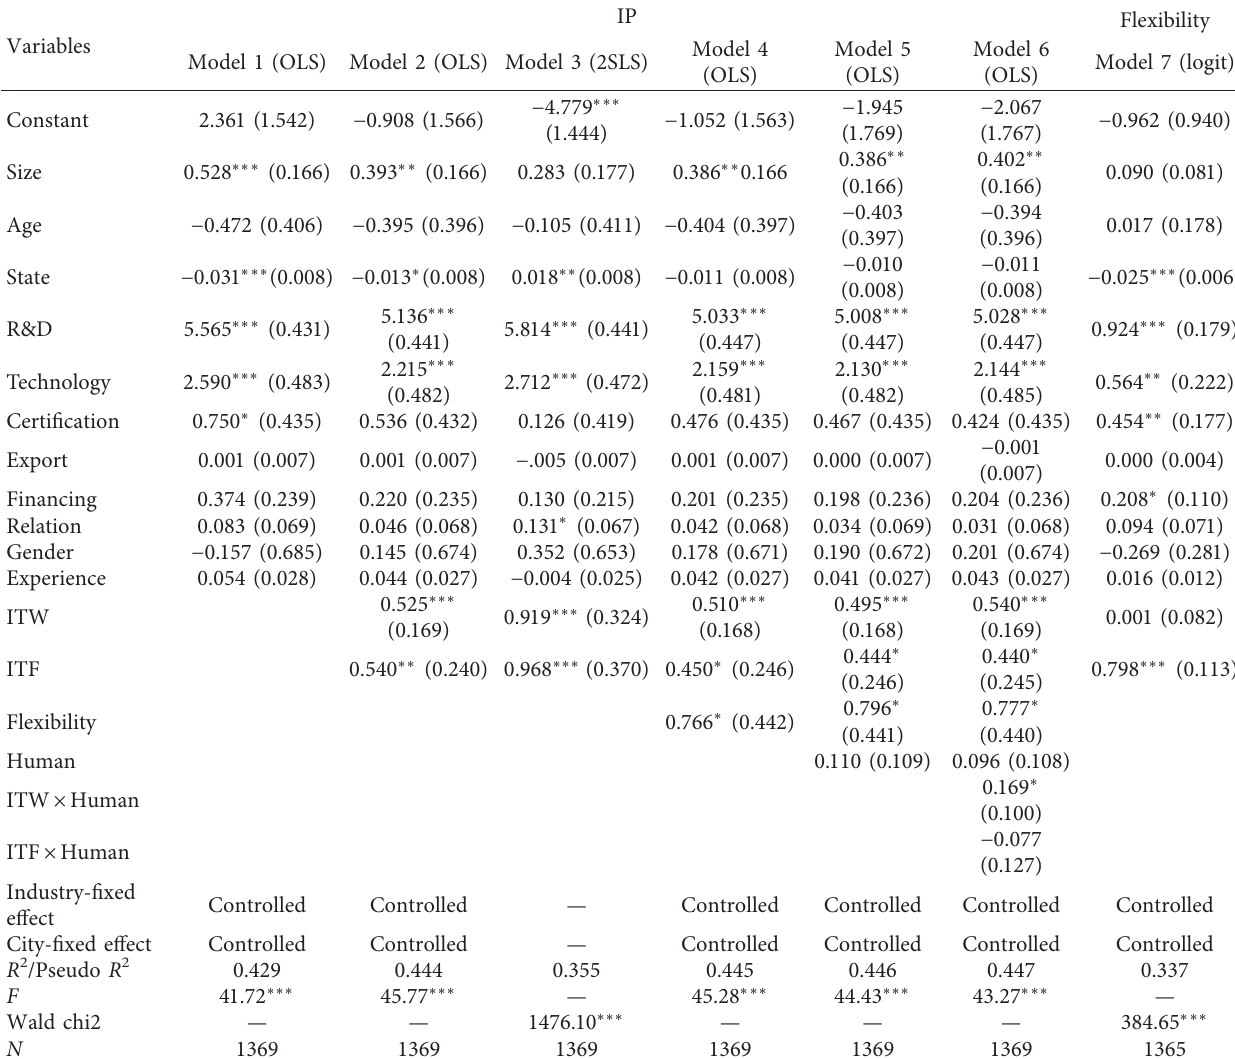
Table 2: Regression